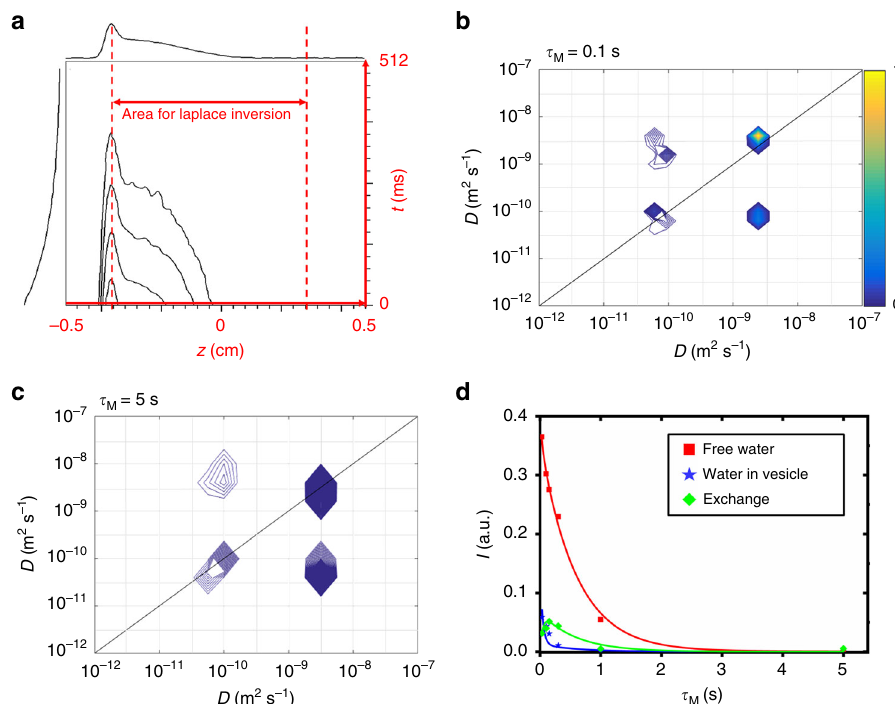
Fig. 3 Ultrafast DEXSY analysis of molecular exchange. a Experimental data after the Fourier transform along the spatial encoding direction measured with a mixing time, τ M , of 1 s. The fi rst row and the fi rst column, which was selected for Laplace inversion, are shown on top and left, respectively. b , c Diffusion exchange maps resulting from 2D Laplace in version of the DEXSY data. d Integrals of the peaks in the diffusion exchange maps and the fi t of two site exchange model to the data points. The fi t resulted in the exchange rate value of k = 28 ± 6 s − 1